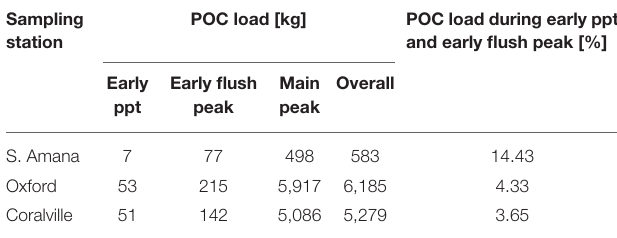
TABLE 6 | POC loads per peak and